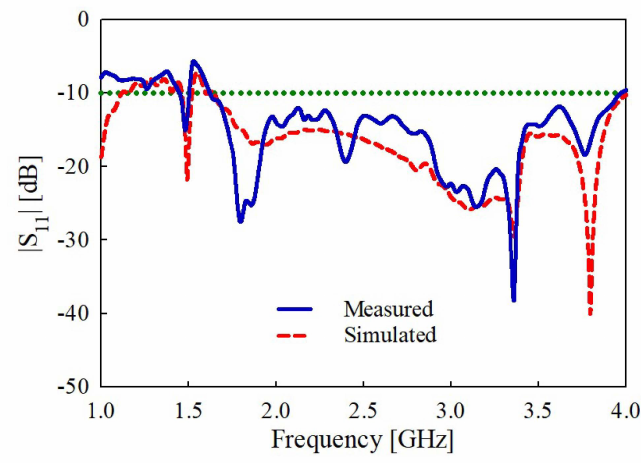
Figure 14. Simulated and measured results of the input reflection coefficient